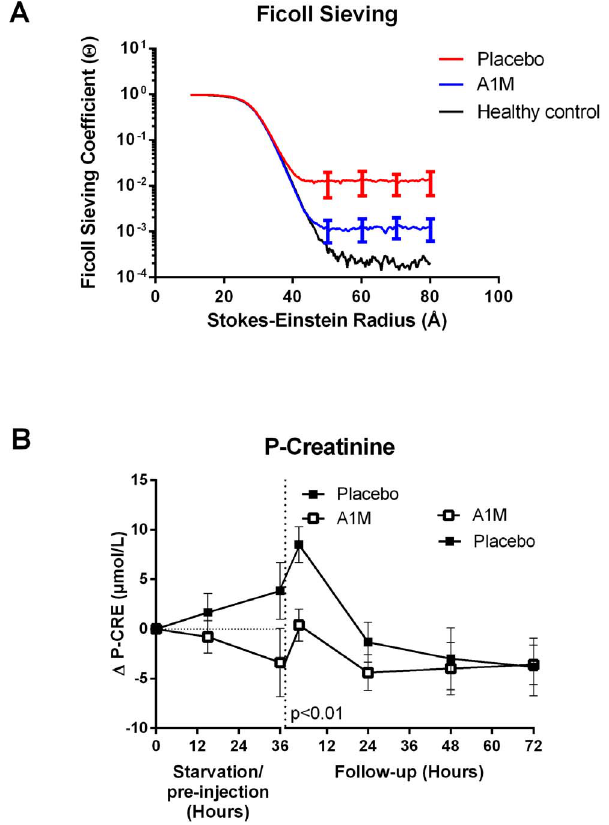
Figure 9. Kidney function. A. Glomerular sieving of FITC-Ficoll. The glomerular sieving coefficients ( h ) plotted vs. Stokes-Einstein radius (a e ), for Ficoll molecules ranging from 10 to 80A˚ in radius. A marked decrease in h for large Ficoll molecules (Ficoll 50–80A˚ ) was seen for the starved group given A1M compared to the starved placebo group. For Ficoll 70 A˚ , h was 1.80 6 10 2 3 6 5.54 6 10 2 4 and 1.18 6 10 2 2 6 5.84 6 10 2 3 (p , 0.055), starved placebo and starved + A1M respectively. The data are presented as the mean 6 SEM and the p-value was calculated using un- paired t-test. B. Plasma creatinine levels. The plasma creatinine levels during the experiment, normalized to experiment start (0 h) -values. The arrows indicate the A1M injections. The data is presented as the mean 6 SEM of D time point X-0h values. The p-values were calculated using un-paired t-test. The indicated p-value is valid for the 4 hour re- fed follow-up time point, which showed significant increase in the plasma creatinine level in the placebo treated